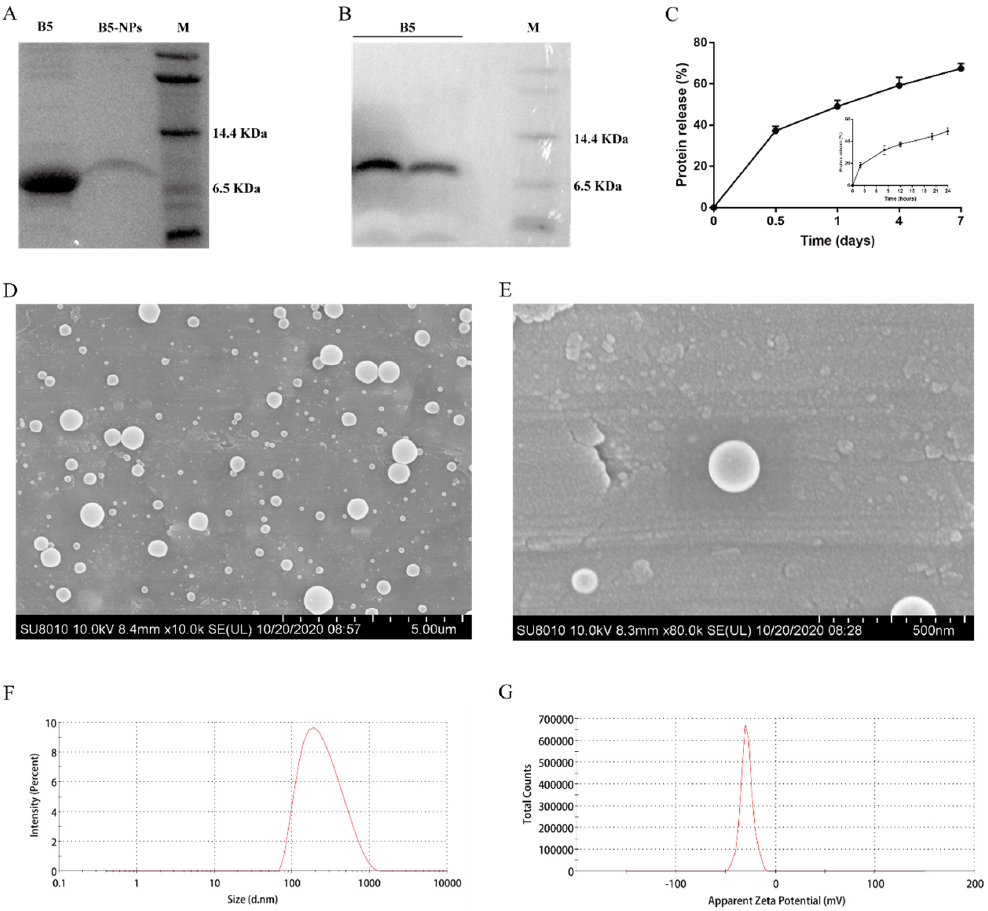
Figure 2. Physicochemical and morphological characterization of B5-NPs. ( A ) The purified recombinant B5 from B5-expressing pichia pastoris cells that was used for the preparation of B5-NPs (left lane). The protein recovered from B5-NPs after 7 days of in vitro release (middle lane) and protein molecular weight ladder (right lane) were subjected to Tricine-SDS-PAGE followed by Coomassie blue staining. ( B ) Western blotting identification of the purified B5 by using anti-His · tag antibody. ( C ) The release profile of B5 protein from B5-NPs in vitro. B5-NPs suspended in PBS (50 mg / mL) were incubated at 37 ◦ C for indicated time periods, and the release of B5 protein was estimated by micro-BCA assay. The initial burst release caused > 45% of B5 protein to be released within 24 h (inner graph), followed by slower-release kinetics that reached ∼ 68% of B5 release by 7 days (outer graph). ( D , E ) Scanning electron microscopy observed the morphological characterization of B5-NPs. ( F , G ) The physicochemical characterization of B5-NPs was determined by dynamic light scattering ( F ) and ζ -potential analysis ( G ). 3.2. B5-NPs Enhance the Cytokine Secretion in J774A.1